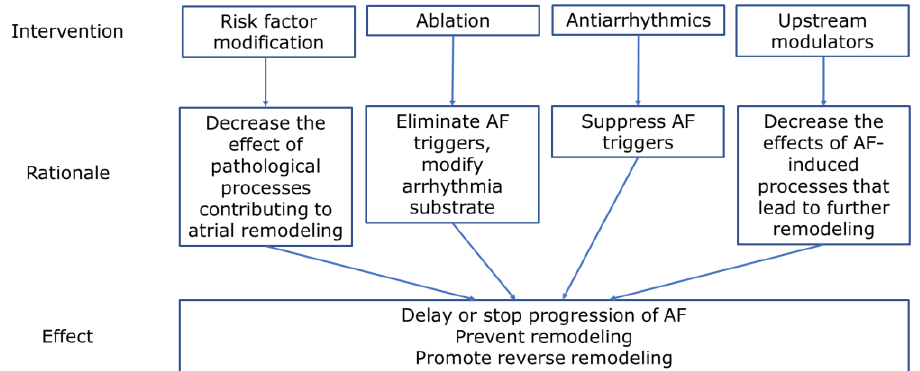
Figure 6. Treatment pathways to prevent the progression of atrial